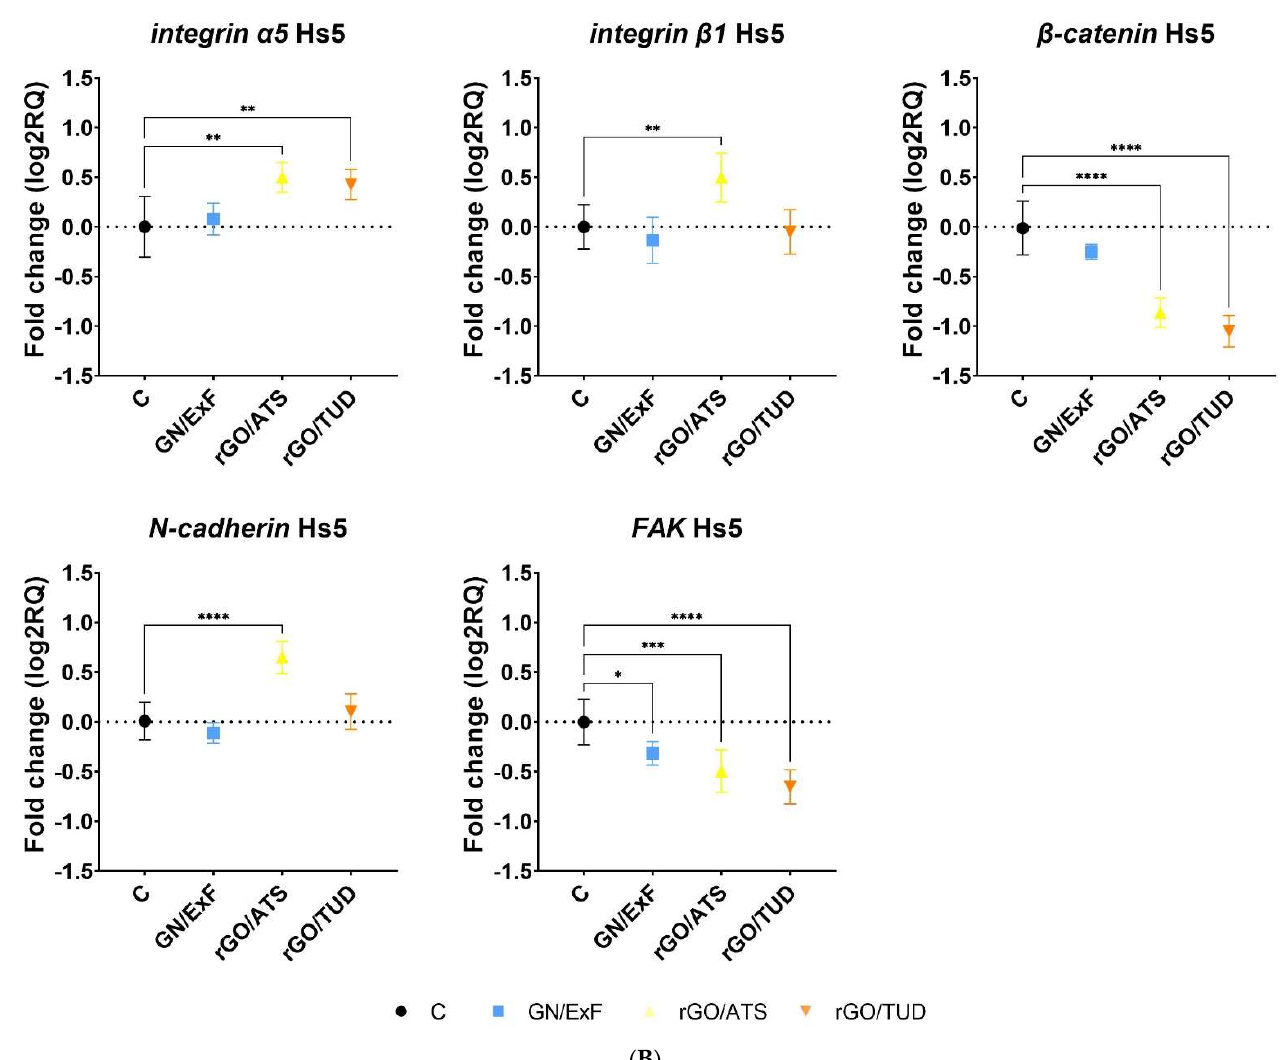
Figure 5. Analysis of the mRNA expression levels of the integrin α5, integrin β1, β-catenin, N-cadherin, and FAK genes after GN and rGO treatment at 25 μg/mL concentration for 24 h in U87 ( A ) and Hs5 ( B ) cells. The results are calculated relative to the control values. Log2RQ (log2 relative quantitation) values for all genes are normalized to the housekeeping gene RPL13A. Statistical significance between the control and the treated cells is indicated by an asterisk and was assessed using Bonferroni’s multiple comparisons test. Differences with p < 0.05 were considered statistically significant. One asterisk (*) indicates p < 0.05, two asterisk (**) indicates p < 0.01, three asterisk (***) indicates p < 0.001 and four asterisks (****) indicate p < 0.0001. Abbreviations: rGO, reduced graphene oxide; GN, graphene; C, control group (untreated group); ExF, exfoliation; Term, thermal; ATS, ammonium thiosulfate; TUD, thiourea dioxide; rpl13a, ribosomal protein L13a; log2RQ, log2 relative quantitation.